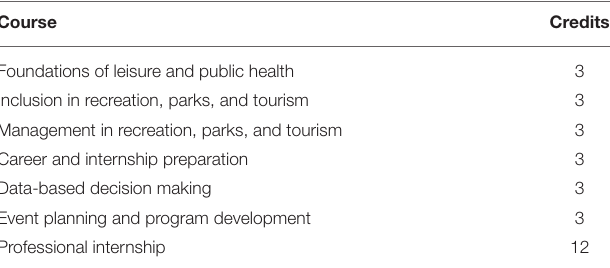
TABLE 1 | Department of health and wellness design undergraduate core